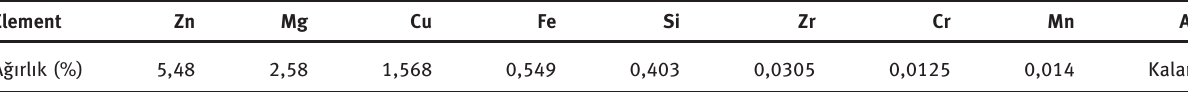
Table 1: The chemical composition of gas atomized AA7075 Aluminum alloy. Element